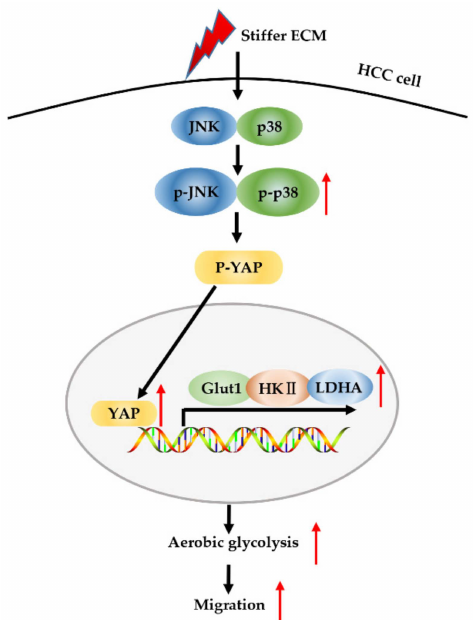
Figure 7. Schematic model for sti ff er ECM-induced MAPK and YAP activation for metabolic reprogramming and migration of HCC cells. Sti ff er ECM stimulates a signaling cascade through activation of MAPK and YAP to transduce biomechanical force. Sti ff er ECM activates JNK and p38 and promotes their phosphorylation. The activated JNK and p38 dephosphorylate YAP and promote its localization in the nucleus. Then, activated YAP increases the expression of glycolysis-related genes, which in turn promotes cell glycolysis and